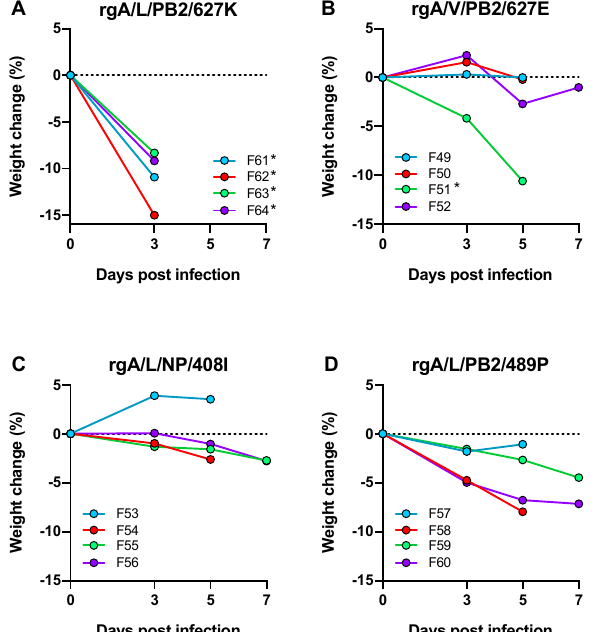
Figure 4. The effect of individual mutations at NP 408I or PB2 489P on pathogenicity. Percentage weight change following intranasal infection of ferrets with ( A ) rgA / L / PB2 / 627K; ( B ) rgA / V / PB2 / 627E; ( C ) rgA / L / NP / 408I; or ( D ) rgA / L / PB2 / 489P viruses. * Ferrets were euthanised earlier than scheduled, at the humane endpoint.